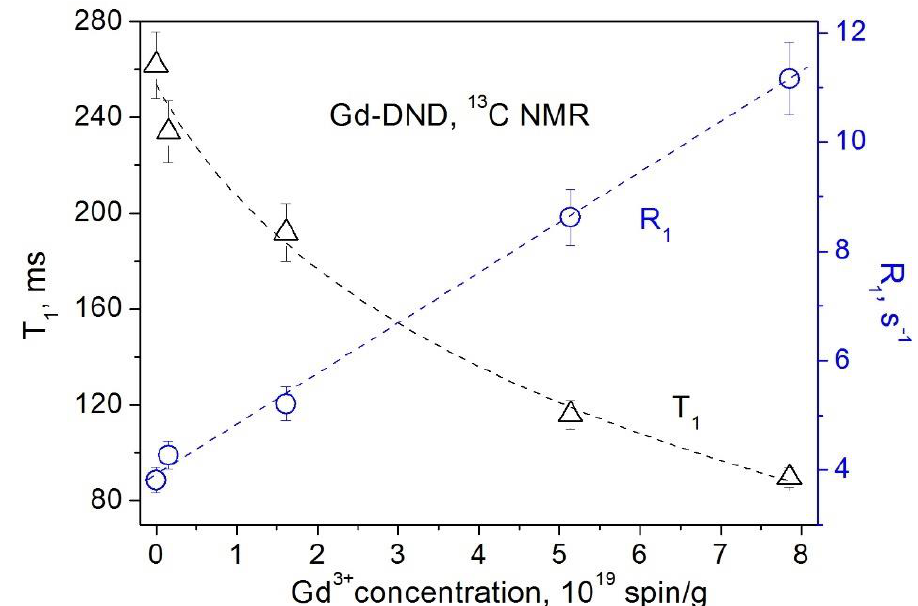
Figure 7. Dependence of the 13 C spin – lattice relaxation rate R 1 (circles) and the spin – lattice relaxa- tion time T 1 (triangles) in Gd-DND powders on the Gd 3+ ion concentration.